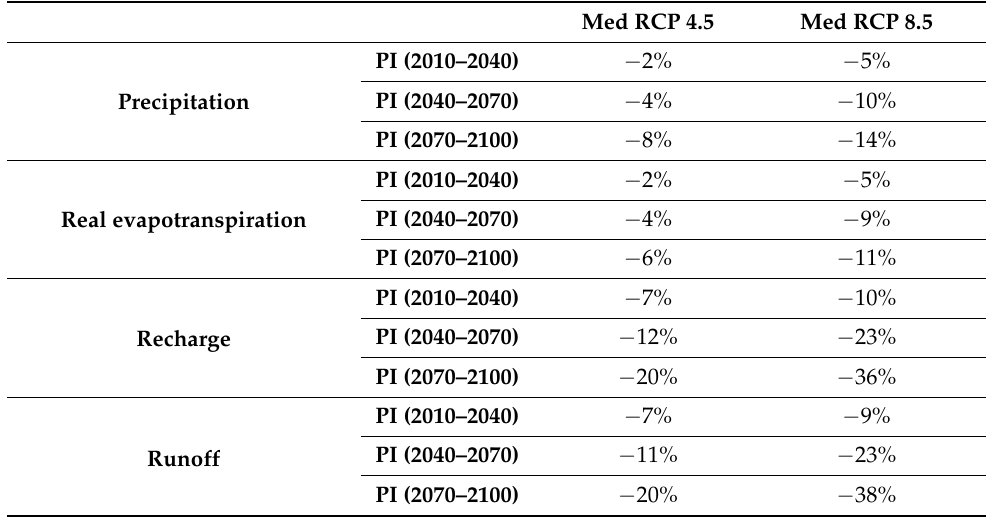
Table 7. Effect of climate change with respect to an unaffected situation on hydrological variables in the